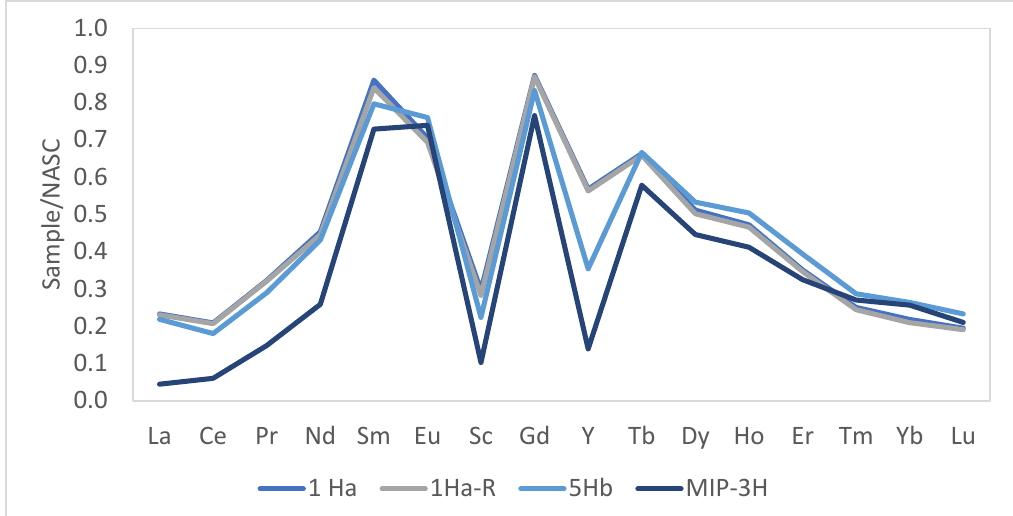
Figure 7. Extracted total REY pattern.